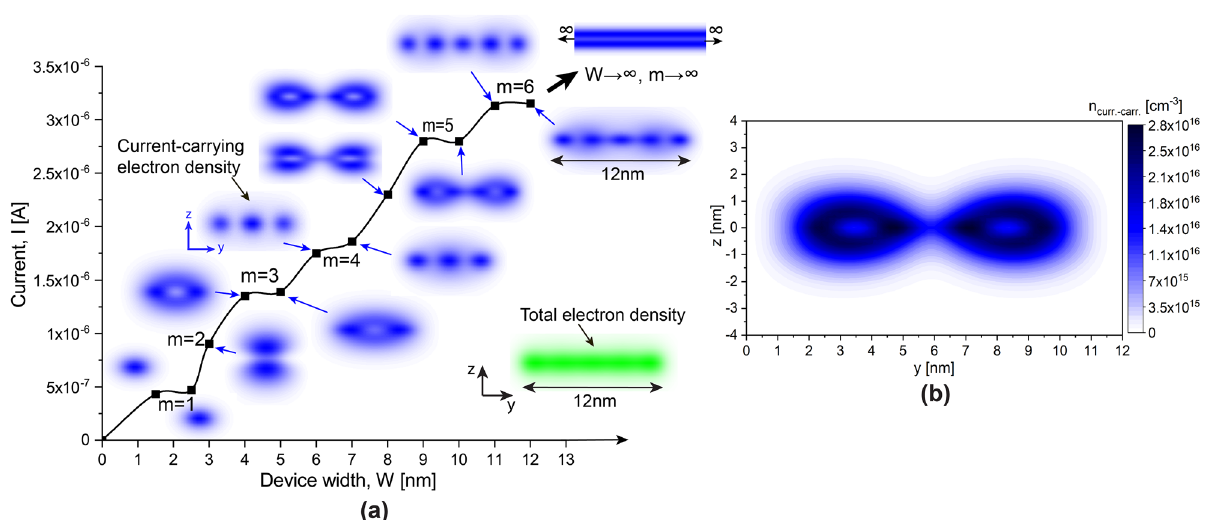
Figure 3. Propagation modes for Si: P δ -layer systems. ( a ) Current I vs device width W for δ -layer systems with 0 nm: the insets in blue color show the spatial distributions of current-carrying modes across a y-z plane, L gap = indicating the corresponding number of propagating modes m ; Inset in green color shows the total electron density that includes all (not just current-carrying) occupied electron states for a device width of W 3 3 ). ( b ) Detail of the spatial distribution of current- 10 20 cm 10 16 cm n curr . (Note that n total carr . ∼ − − ∼ ≫ − , z ) for a device width of W 9 nm . For all calculations, N carrying states n curr . carr . ( y = 3 , t − 0.2 nm and an applied voltage of 1 5.0 10 17 cm N A − = = ×